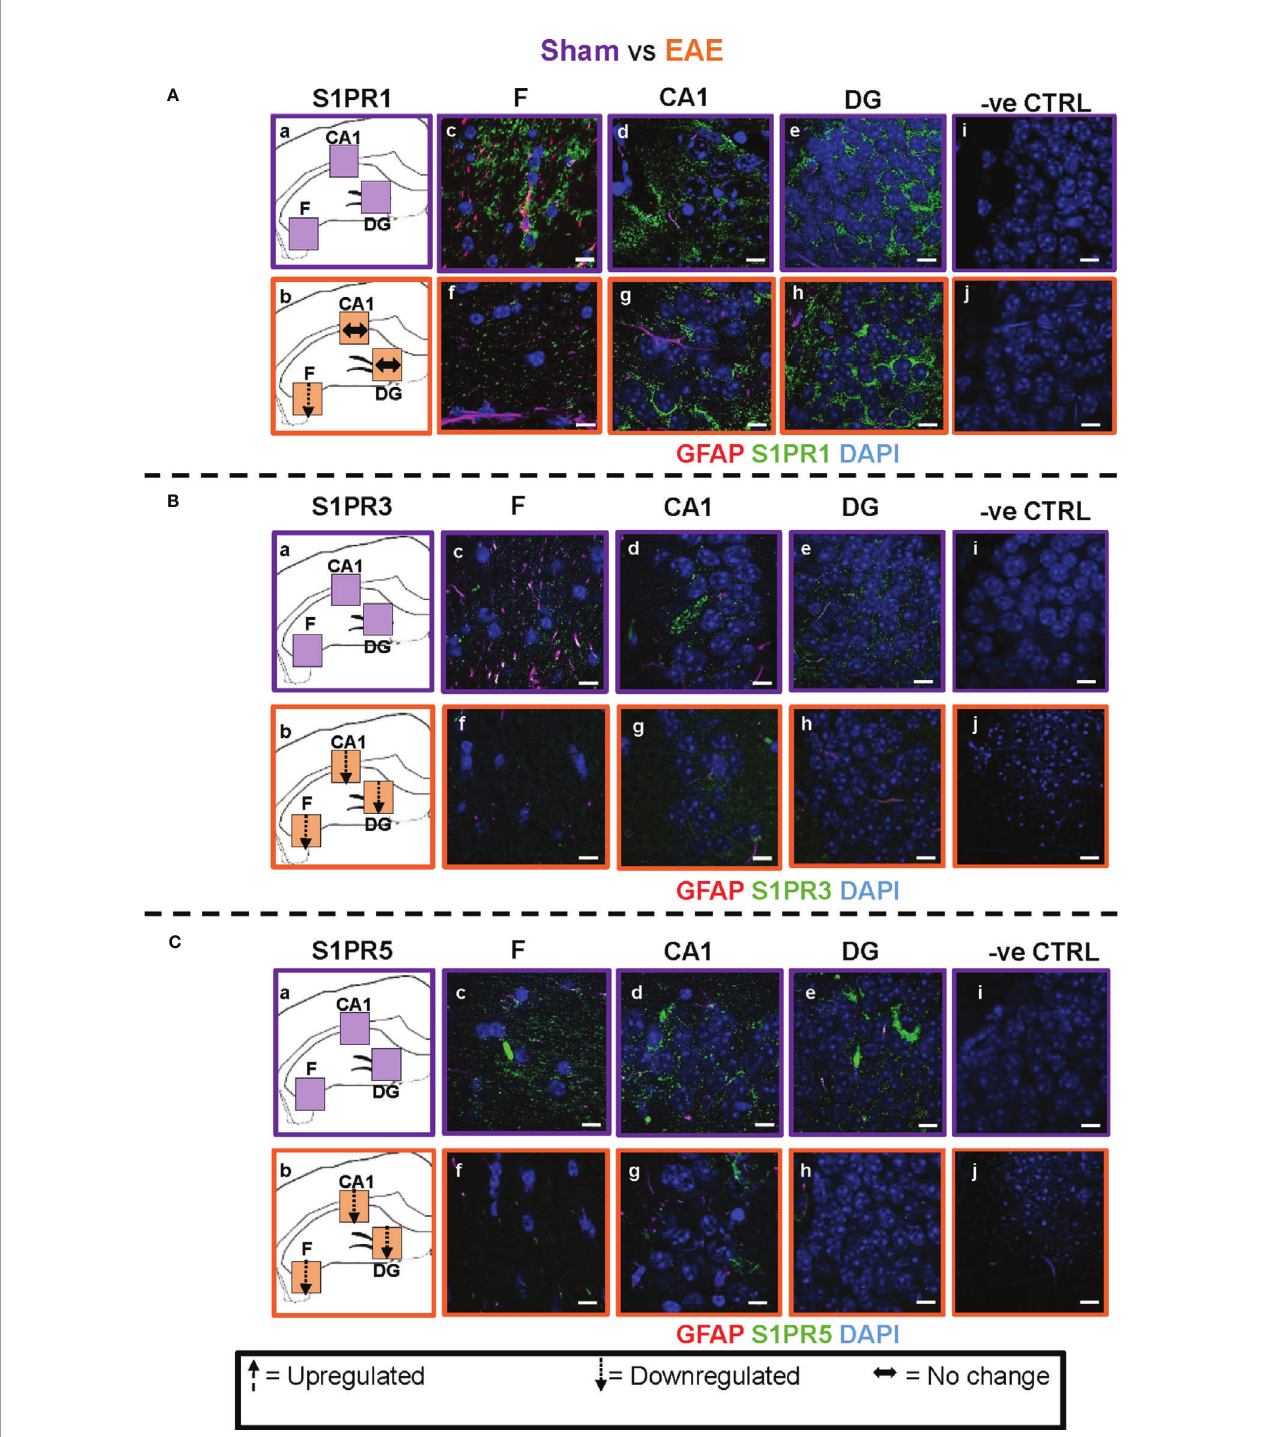
FIGURE 4 | EAE effect on S1PR1, S1PR3 and S1PR5 expression in the hippocampus. Comparison of S1PR expression between sham (purple) and EAE (orange) groups. The left-hand panel shows the regions of interest (Aa-c, Ba-c, Ca-c) and the direction of change in three hippocampal sub- fi elds for each S1PR (downregulation = dotted arrow, upregulation = dashed arrow, or no change = horizontal arrow). The main panel shows immunostained sections with anti-GFAP (red) and anti-S1PR1 (green; Ac-e, f-h ), anti-S1PR3 (green; Bc-e, f-h ) or anti-S1PR5 (green; Cc-e, f-h ); nuclei were stained with DAPI. No primary antibody controls are shown in Ai-j, Bi-j and Ci-j ). Scale bars = 10 µm. Experiments were replicated 3 times. Quanti fi cation of images is shown in Figure 7